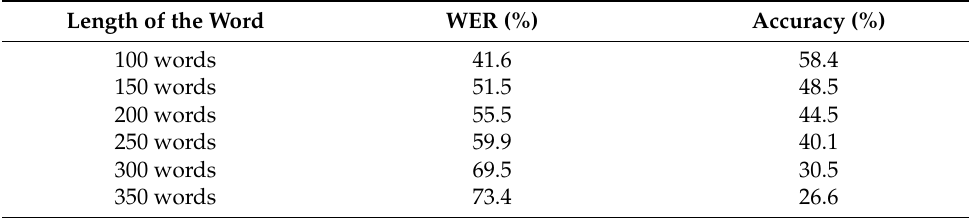
Table 2. WER and its percentage after using ISE.